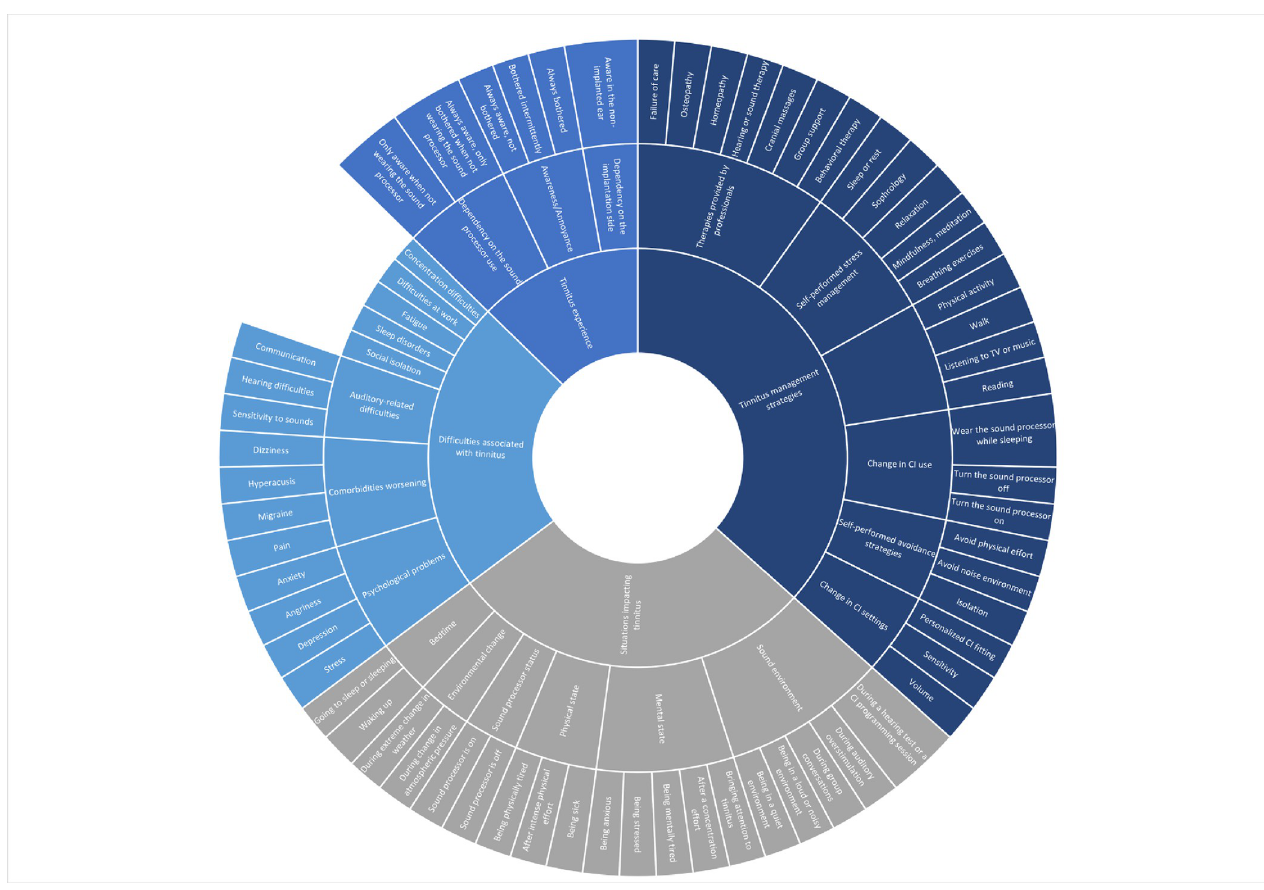
Fig 2. Themes, sub-themes, and codes from the thematic